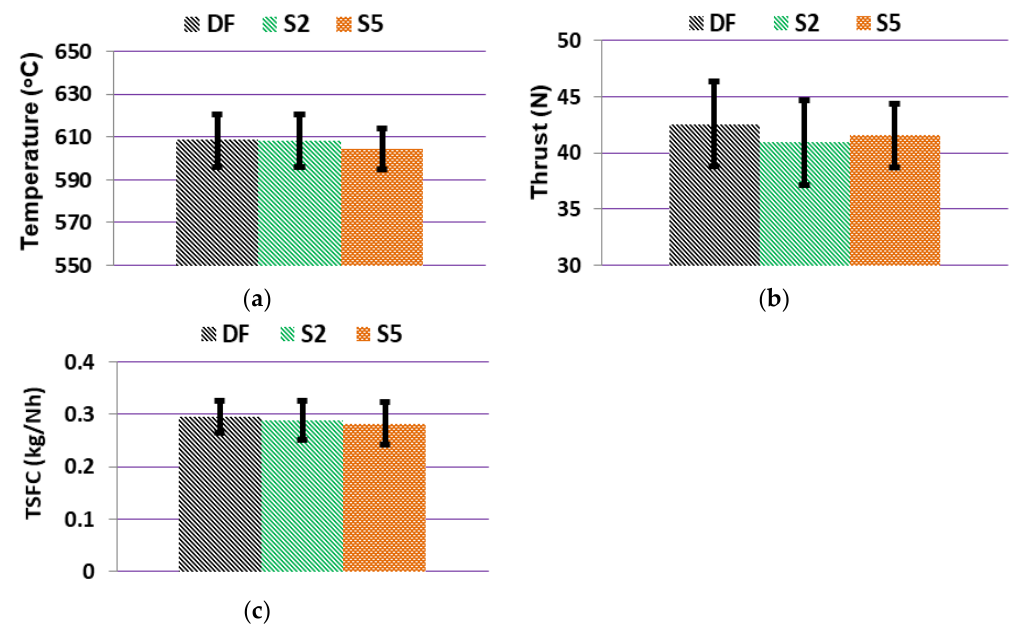
Figure 6. Gas turbine operating parameters at 80k rpm; ( a ) temperature behind the combustion chamber, ( b ) thrust, ( c ) thrust-specific fuel consumptions.